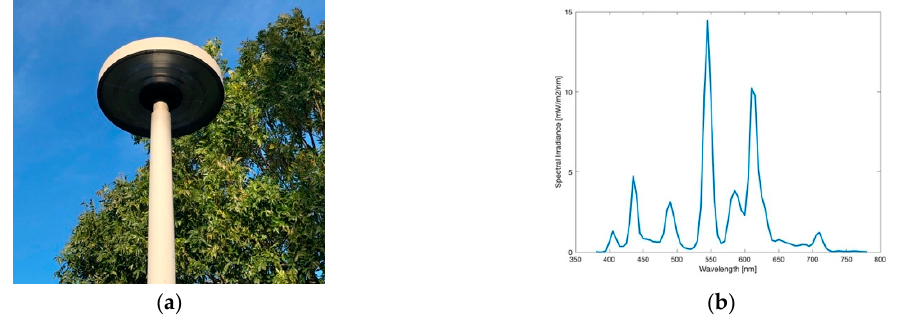
Figure 11. ( a ) Image of the ring-shaped light during daytime; ( b ) Spectrum of lamp observed.